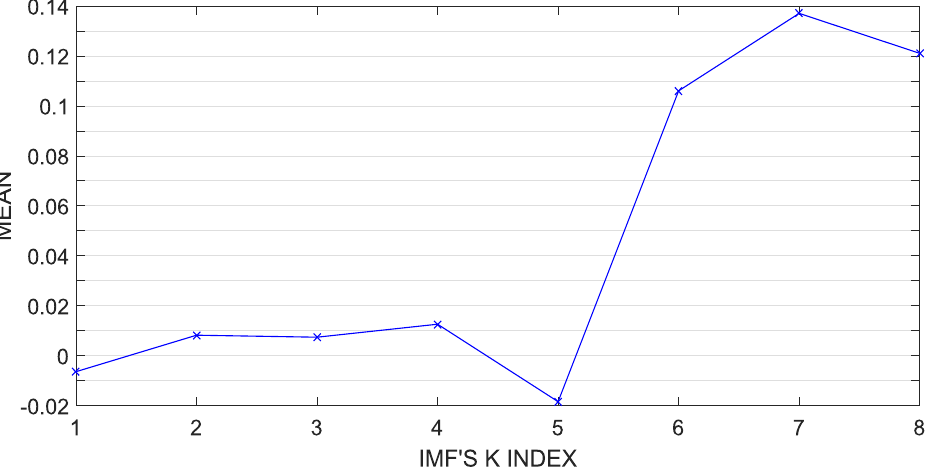
Figure 4. The mean of the IMF’s K index.